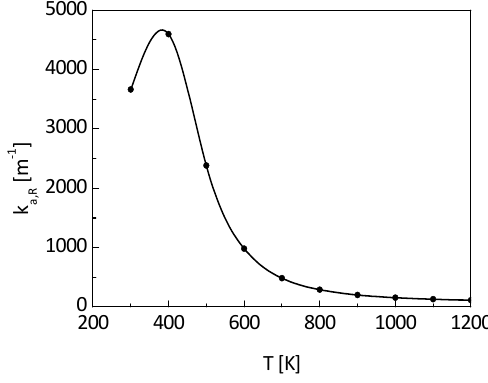
ffi cient of the